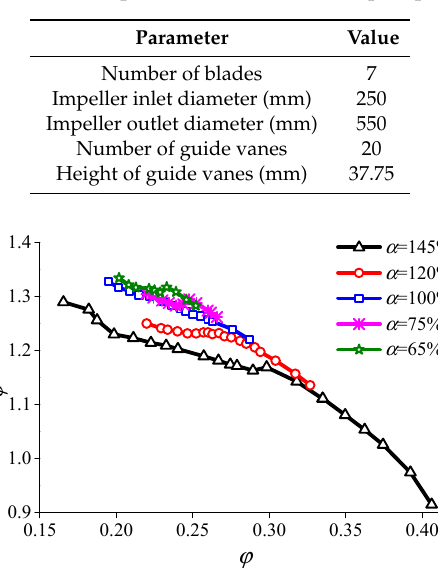
Table 1. Geometric parameters of the model pump-turbine.